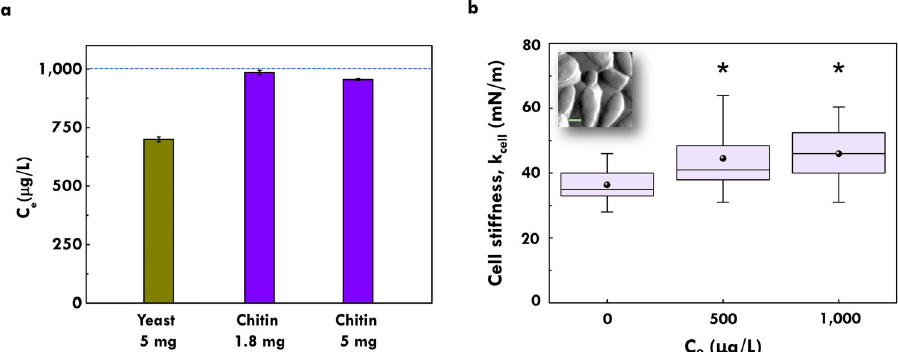
Fig. 5 Chitin ’ s contribution to Pb 2 + adsorption and nanomechanical characterization of yeast biomass. a Pb 2 + C e after biosorption experiments with 5 mg of yeast biomass (green bar), 1.8 mg, and 5 mg of chitin (purple bars); blue dotted line represents C 0 : 1000 ppb Pb 2 + . b AFM analysis of yeast cell stiffness. Box and whisker plots of the cellular spring constant ( k cell ) calculated from force-extension curves acquired from yeast cells incubated with C 0 of 0, 500, and 1000 ppb Pb 2 + . Boxed region indicates upper and lower quartiles for each data set; median is indicated by the horizontal line within the box; mean is indicated by the bullet point; whiskers extend to high and low data points ( n > 70 force measurements from ≥ 8 cells per condition). Asterisk indicate p < 1e-5 by single factor ANOVA test between cell groups incubated with C 0 of 0 ppb and 500 ppb, or 1000 ppb Pb 2 + . AFM de fl ection retrace image of yeast cells is shown in the inset (scale bar: 2 μ